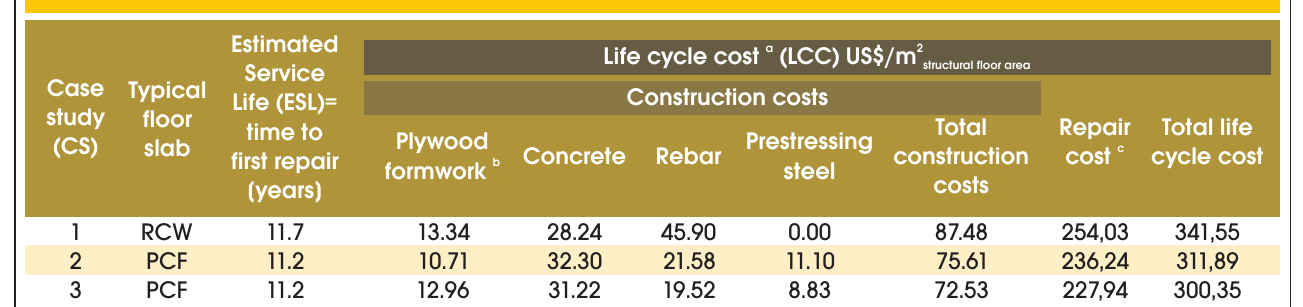
Table 5 – Service life estimated by Life-365 v.2.1.1, ESL (time to first repair) and life cycle cost of a typical floor of each case study